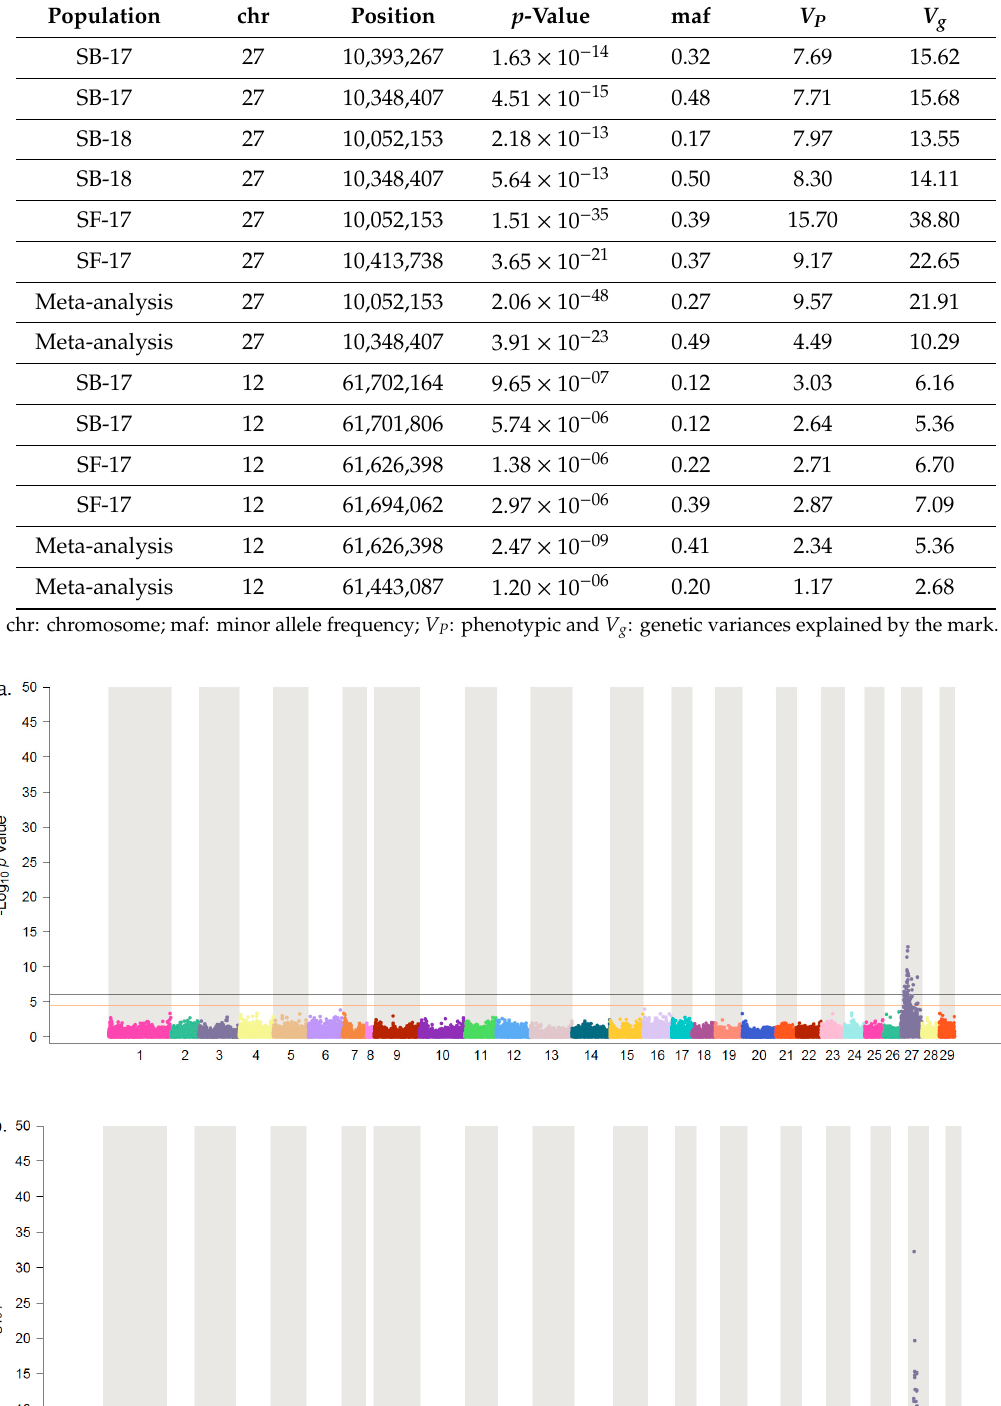
Table 2. Summary statistics of the top two quantitative trait loci (QTL) associated single-nucleotide polymorphisms (SNPs) per-population that passed the genome-wide or chromosome-wide significance threshold.